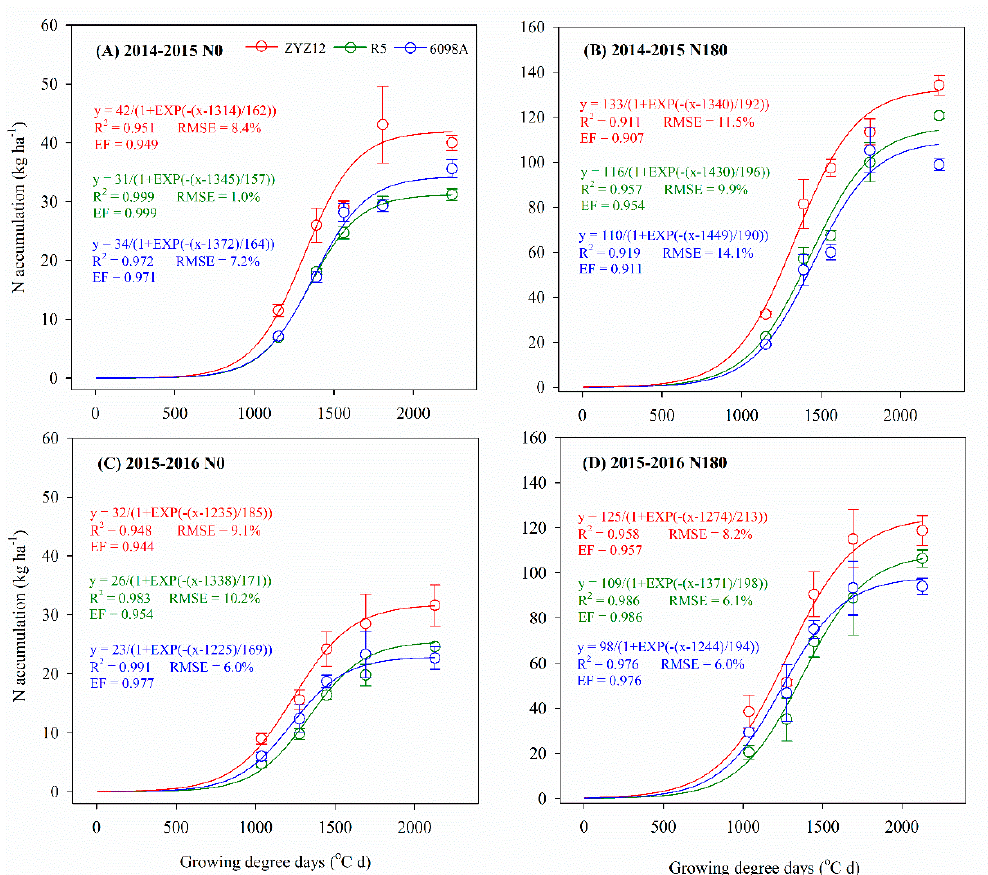
Figure 3. Dynamics of the measured and simulated values of nitrogen accumulation in three oilseed rape cultivars under 0 and 180 kg ha − 1 N supply in the 2014–2015 ( A , B ) and 2015–2016 ( C , D ) seasons.